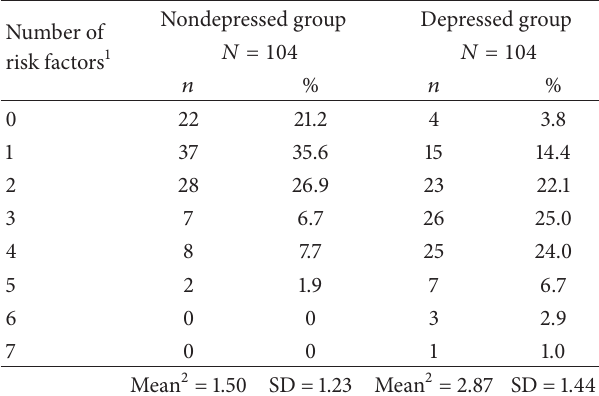
Table 2: Number of risk factors in the nondepressed and depressed